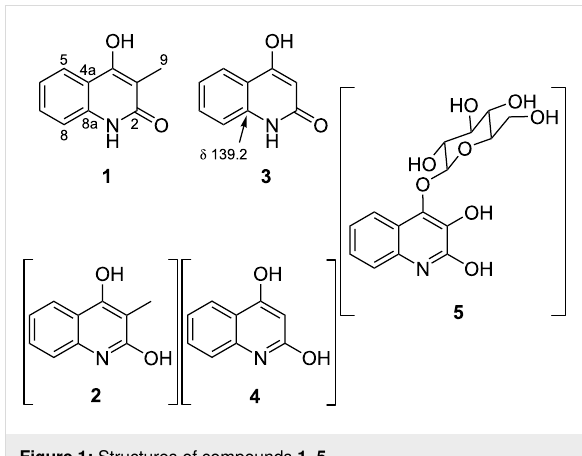
Figure 1: Structures of compounds 1 – 5